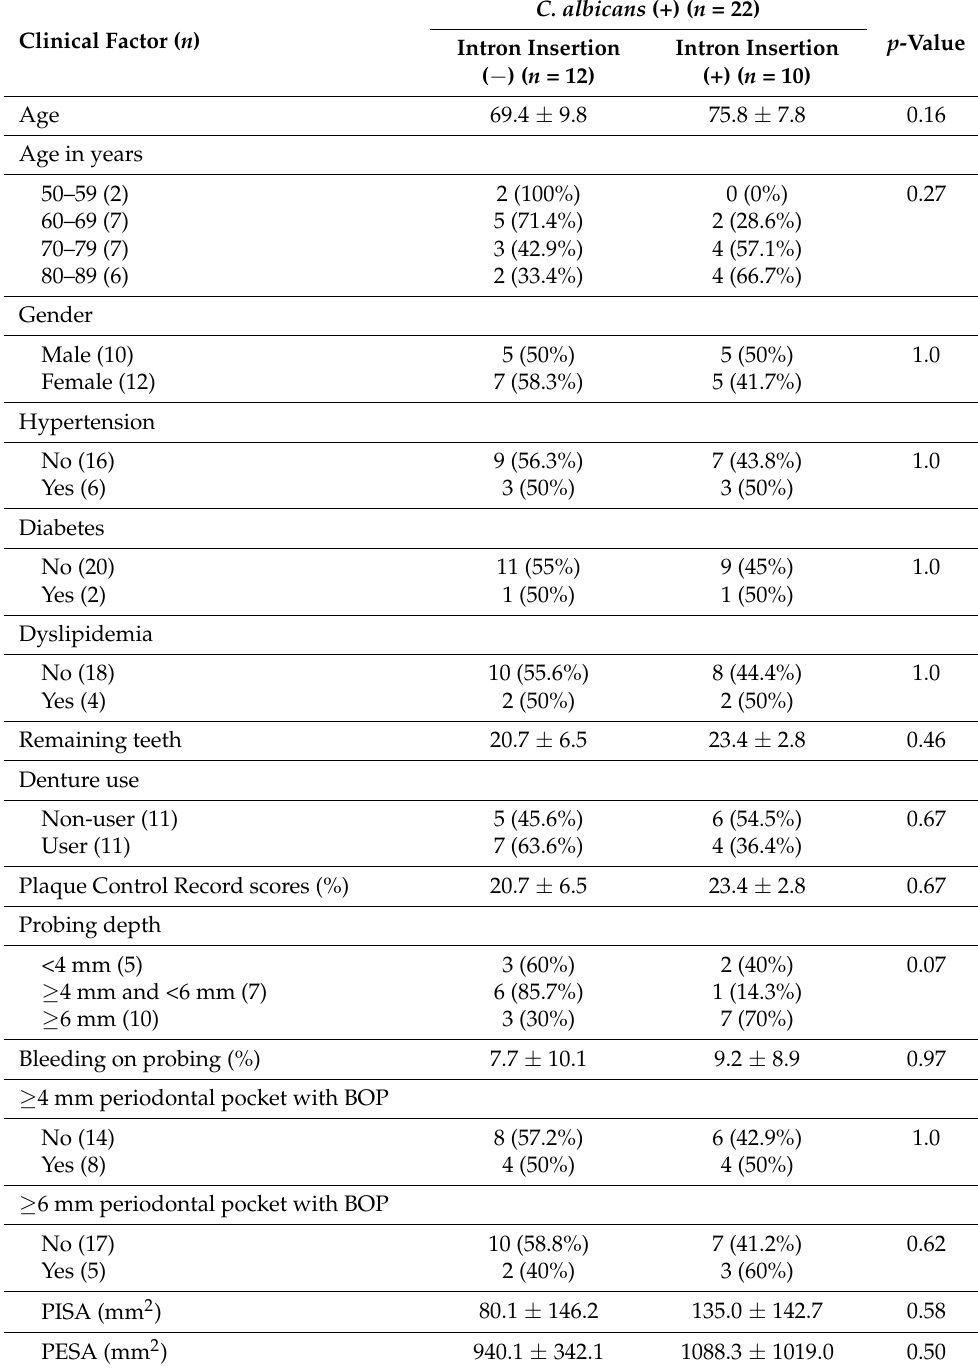
Table 2. Relationship between intron insertion of C. albicans and clinical factors in C. albicans -positive